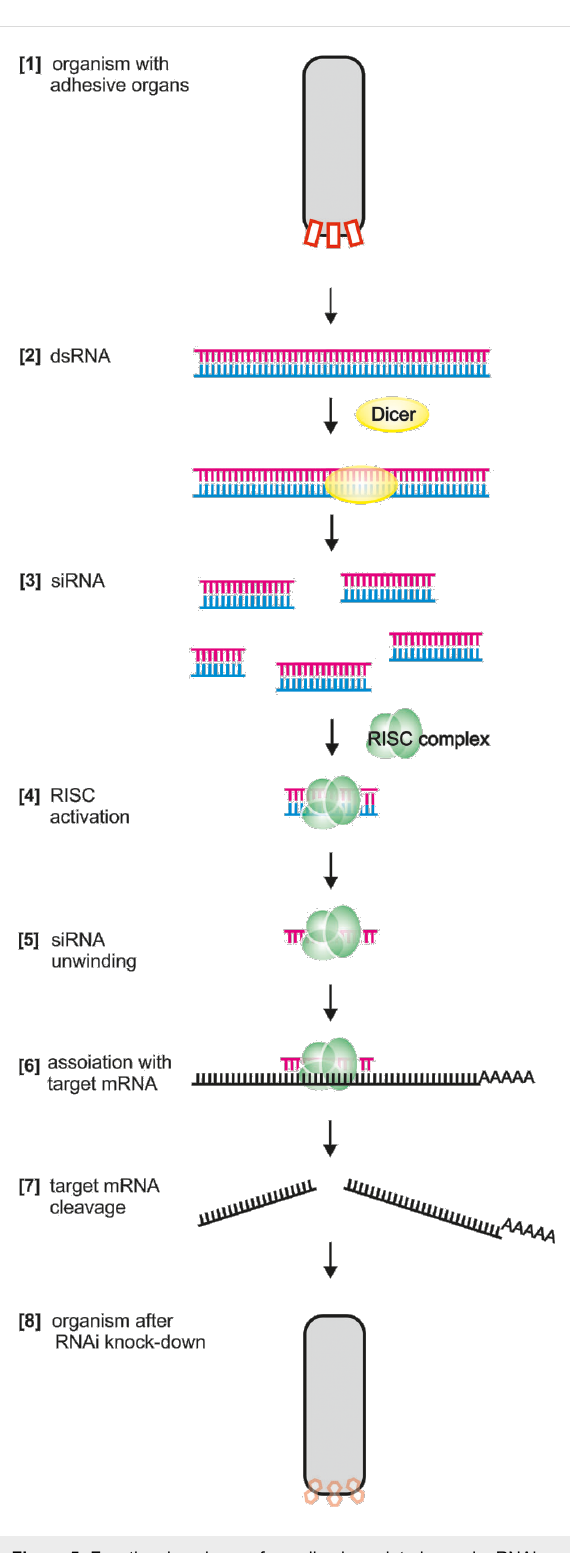
Figure 5: Functional analyses of an adhesion-related gene by RNAi. After the application of dsRNA the mRNA gets degraded. The lack of the corresponding protein affects the function of the adhesive struc- ture and the organism is unable to attach if an essential adhesion- related gene has been targeted. See text for